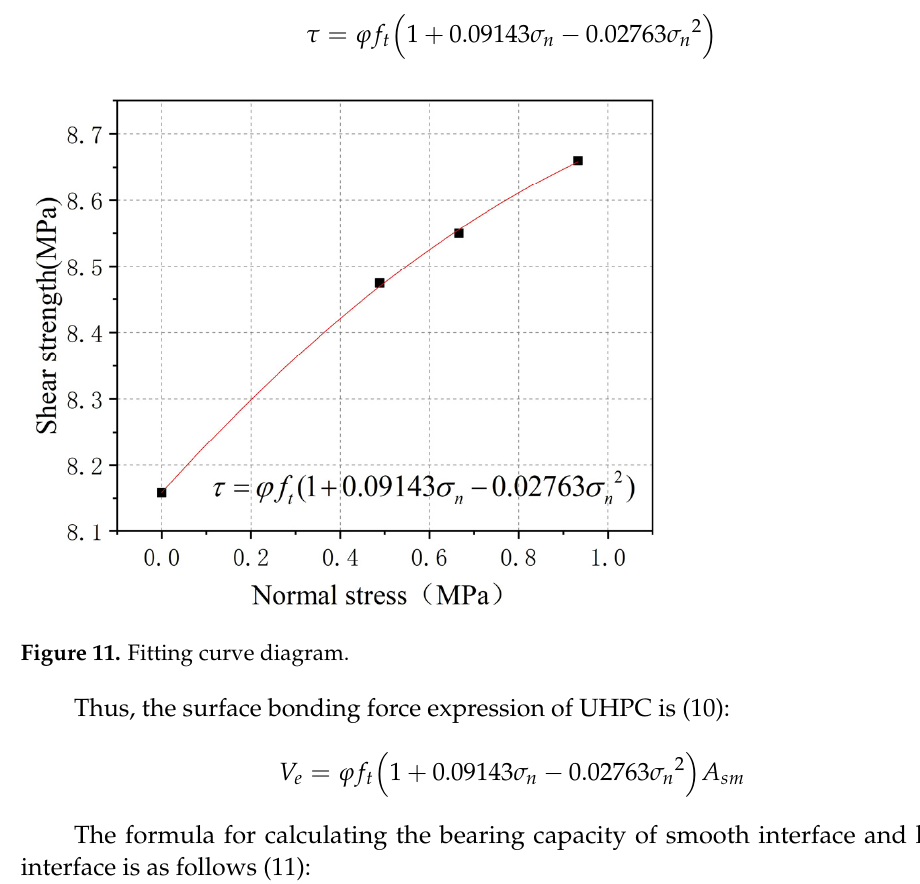
Table 5. Comparison of Formula and Experimental Results.